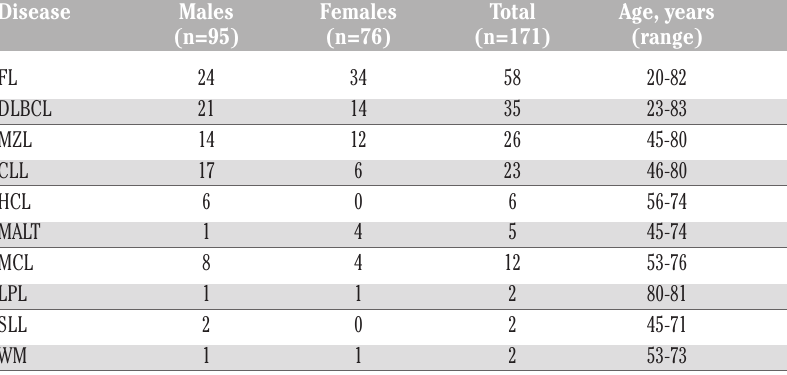
Table 1. General characteristics of patients.